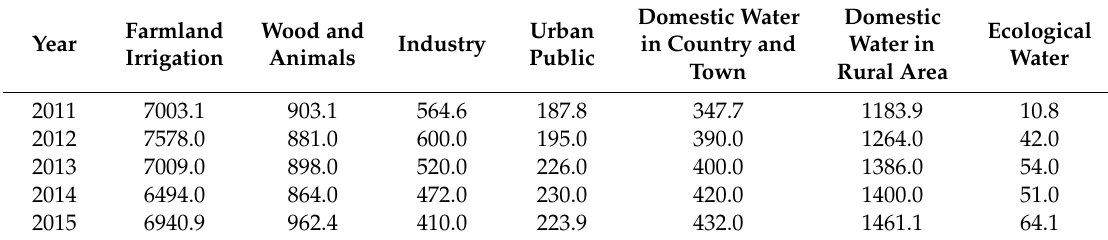
Table 2. Pumping water volume of groundwater for each user (unit: 10 4 m 3 /